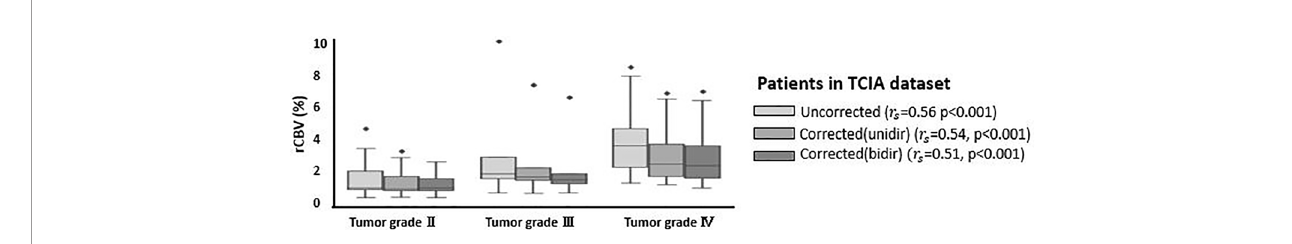
FIGURE 6 | Boxplots of uncorrected, unidirectional corrected and bidirectional corrected rCBV values per each grade (grade II, III, and IV). r s represents the correlation coef fi cient between rCBV and tumor grade, derived from Spearman rank correlation test. *Signi fi cantly different, p